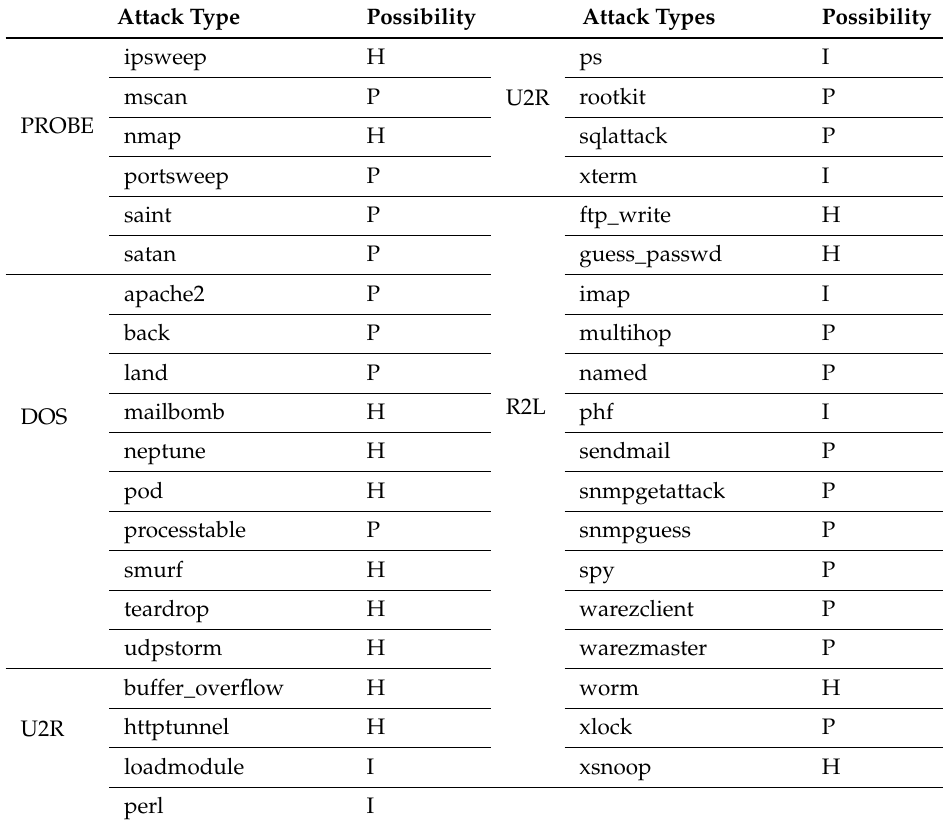
Table 3. KDD99 sub-attacks possible in